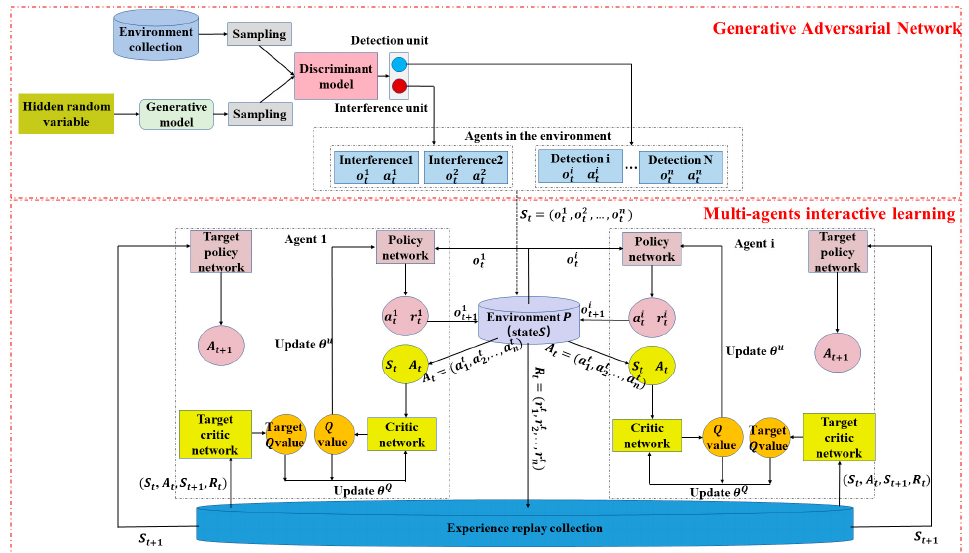
Figure 1. Interactive self-learning game and evolutionary system based on non-cooperative equilib-